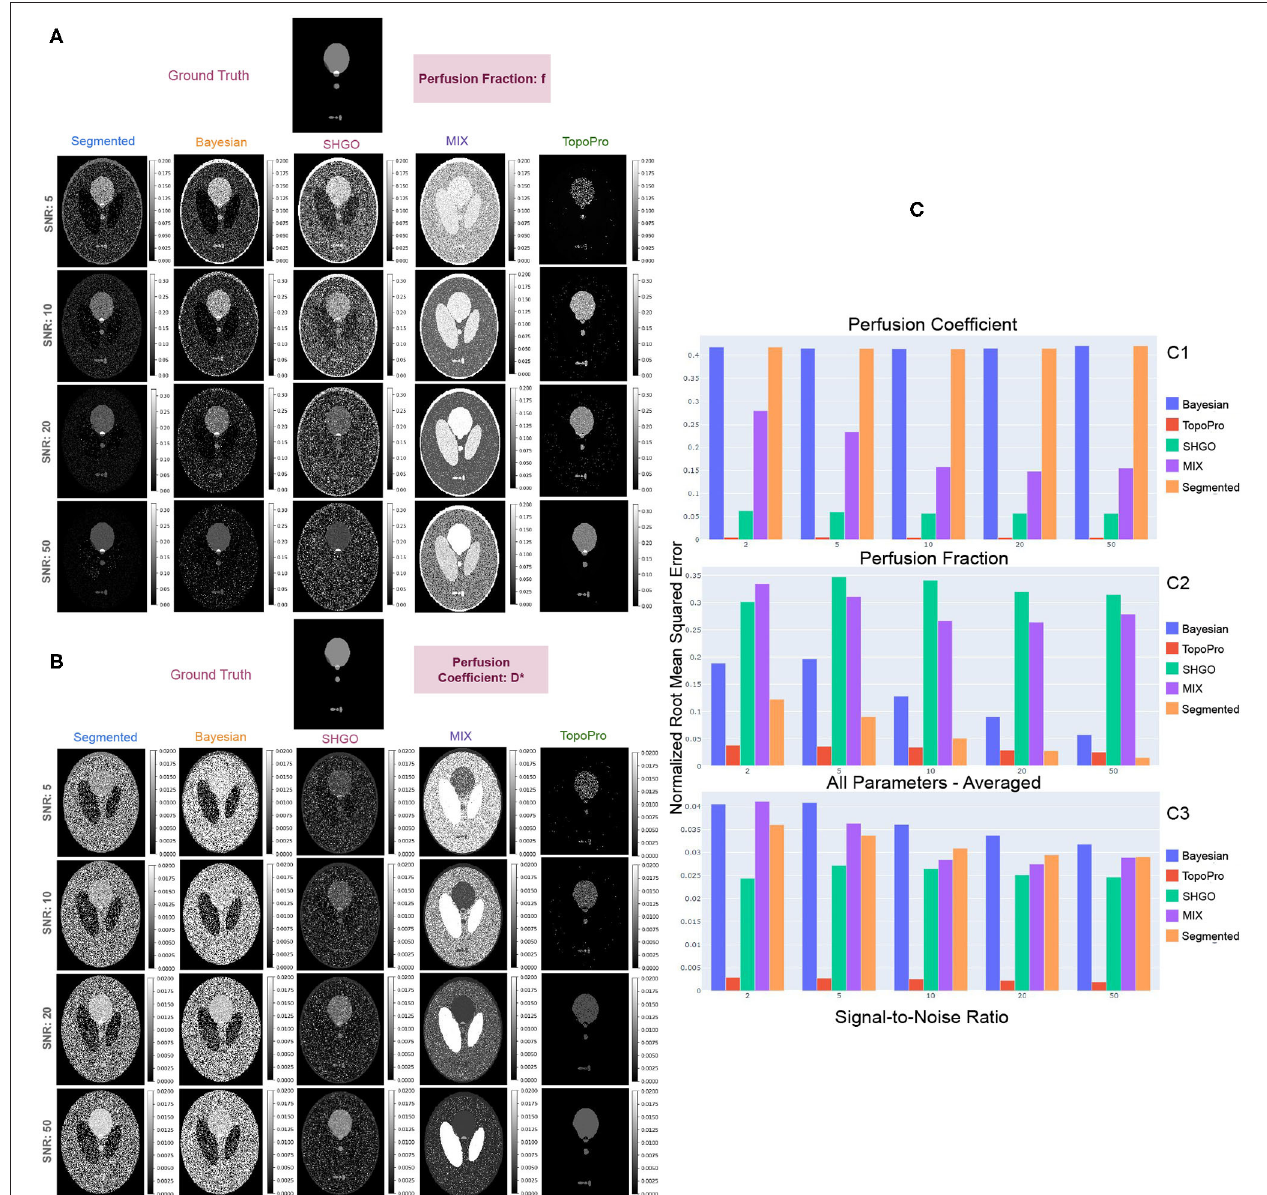
FIGURE 5 | Shows results with the simulated Shepp-Logan phantom for different tumors. In (A,B) , we show a qualitative comparison of the simulated data at different SNRs by comparing TopoPro against segmented, Bayesian, SHGO and MIX fitting. The ground truth for each of the model parameters f and D ∗ are depicted at the top of their respective estimates with different methods. (C) Compares the Root Mean Squared Error of the fits for both D ∗ (C1) and f (C2) and its average for all model parameters (C3) for each SNR. Notice that TopoPro outperforms the other fitting methods by 10X in the estimation of D ∗